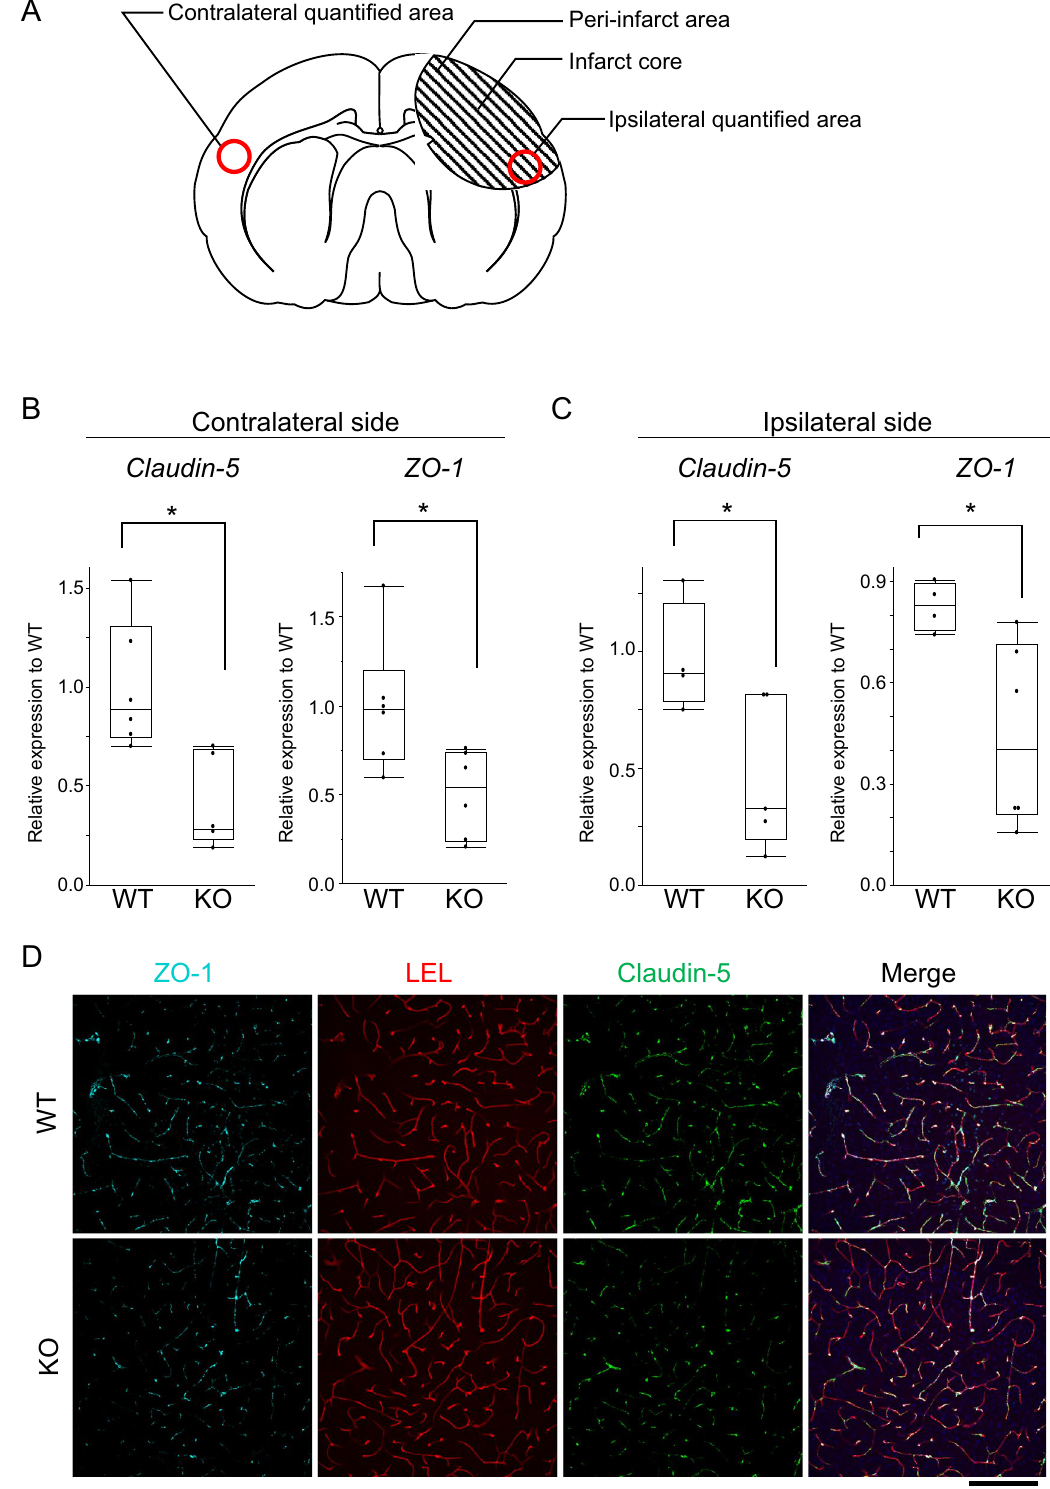
Figure 4. Sections of 30-µm thickness and mRNA expression level of tight junction proteins. The mRNA expression levels were quantified in the peri-infarct area shown in ( A ). The expression levels of ZO-1 and claudin 5 are decreased in occludin-deficient mice ( B – D ). The box and whiskers with maximum and minimum of relative mRNA expression levels in wild-type mice and occludin-deficient mice are shown in ( B and C ). The mRNA expression levels of claudin-5 and ZO-1 in the contralateral side of the cerebral infarction (left: claudin-5; right: ZO-1) and on the ipsilateral side (left: claudin-5; right: ZO-1) are decreased. Immunofluorescent analyses of 30-µm thick sections are shown in ( D ). Unpaired t-tests are used. * P < 0.05. Scale bar = 200 µm. n = 4–6 each. LEL: lycopersicon esculentum